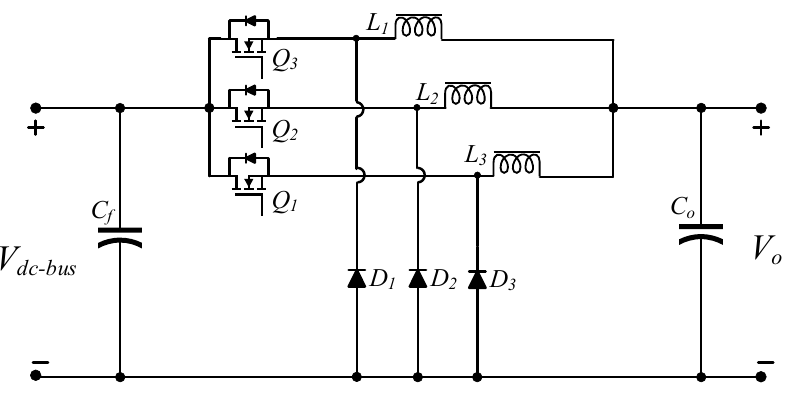
Figure 19. Three-phase interleaved Buck converter.